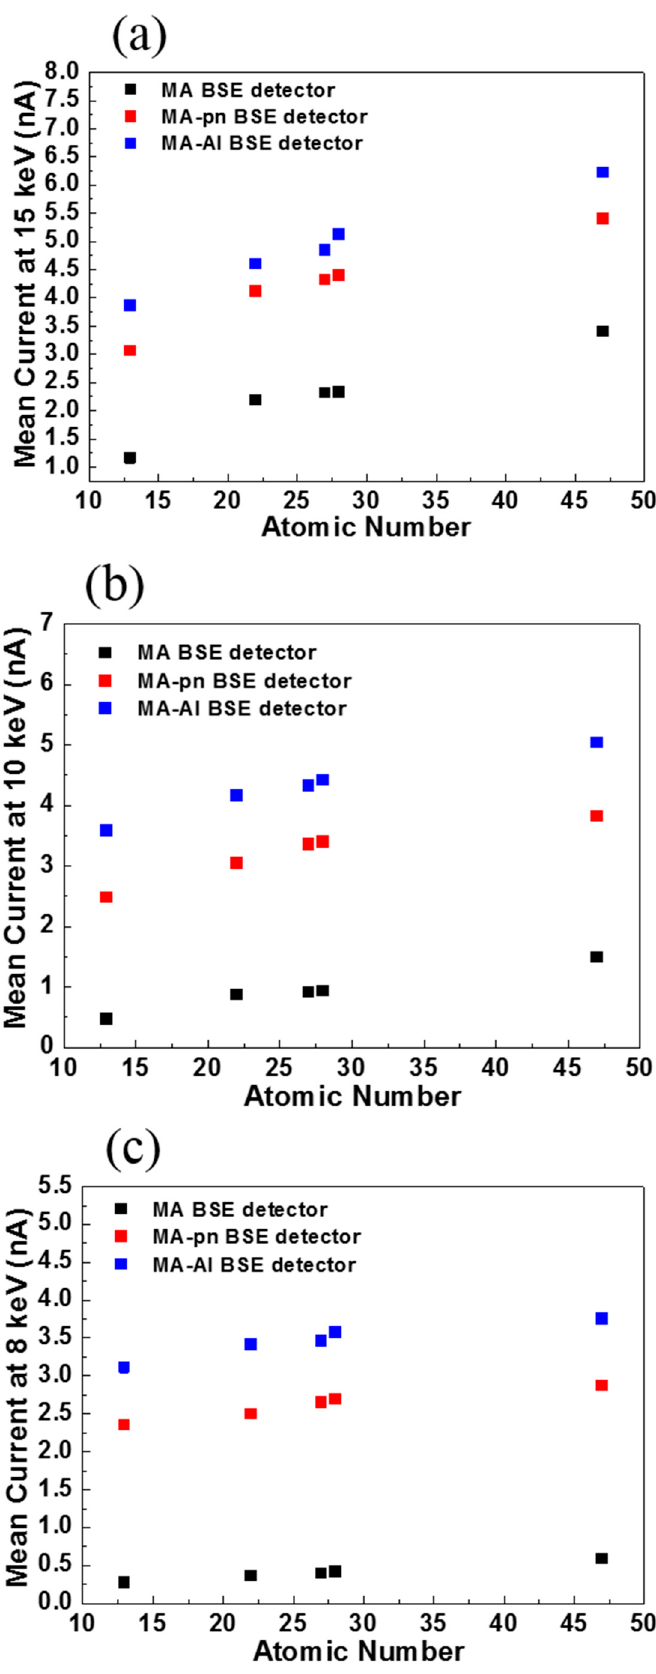
Figure 9. Sensitivity of atomic number for three type detectors at electron energy of ( a ) 15 keV, ( b ) 10 keV and ( c ) 8 keV.